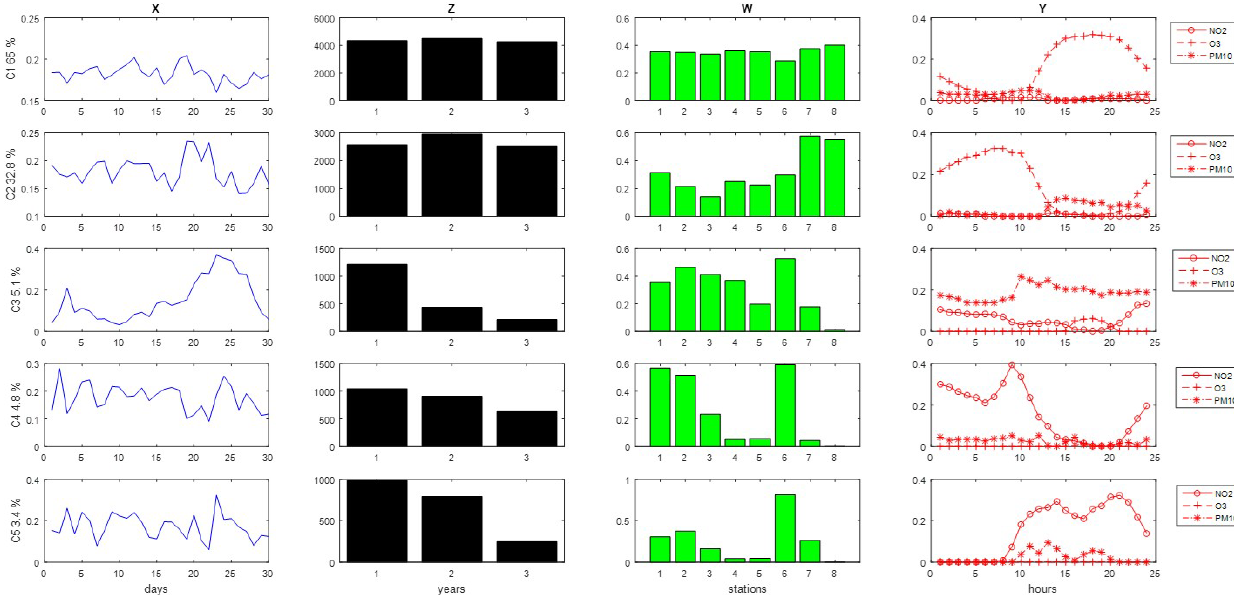
Figure 7. MCR-ALS analysis of NO 2 , O 3 and PM 10 concentrations in the column-wise super-augmented incomplete April data matrix DA12 craug (see Eq. 9) using non-negativity and quadrilinearity constraints. Profiles of the four different data modes are given in different colors: (X) in blue – days of the year; (Z) in black – year 1 = 2018, 2 = 2019 and 3 = 2020; (W) in green – stations 1: Vall d’Hebron, 2: Granollers, 3: Manlleu, 4: Juneda, 5: Bellver, 6: Gràcia, 7: Begur, 8: Observatori Fabra; and (Y) in red – hours of the day.